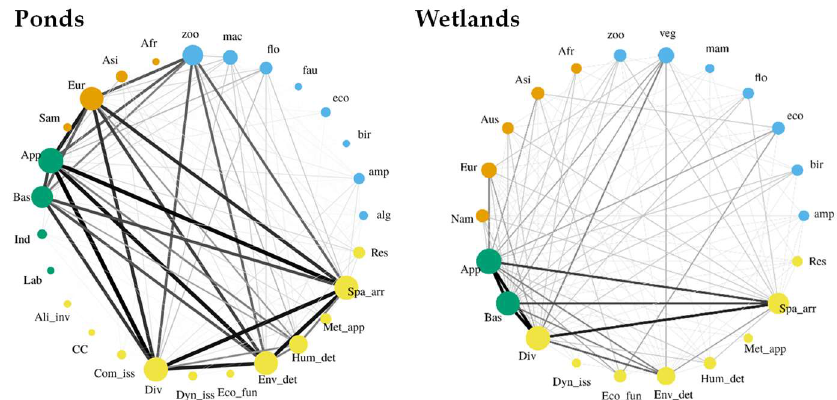
Figure 3. Representativeness and links (as reported in the legend, expressed in number of links; see Table 1) among the descriptive topics evaluated by matrix method (biotic target ( light blue ; zoo, mac, flo, fau, eco, bir, amp, alg); target issues ( yellow ; Res, Spa_arr, Met_app, Hum_det, Env_det, Eco_fun, Dyn_iss, Div, Com_iss, CC, Ali_inv); research type ( green ; Lab, Ind, Bas, App); and the geographical location of investigated aquatic ecosystems ( orange ; Nam , Eur, Aus, Asi, Afr) for ponds and wetlands; for definitions of the topic categories see Table 1.